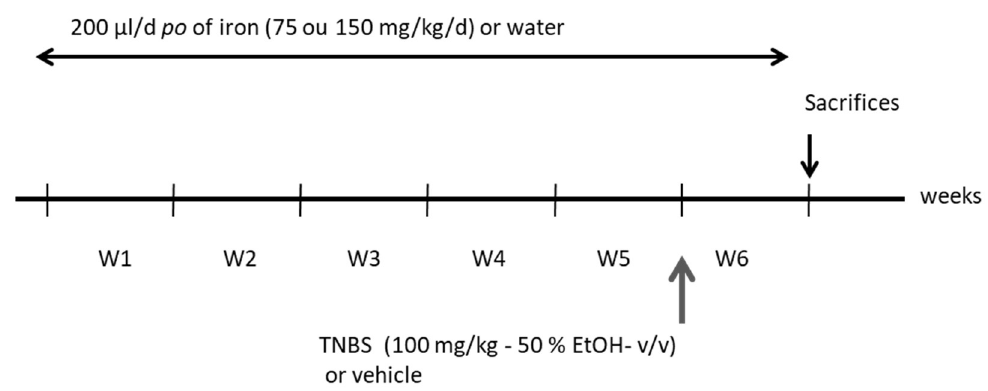
Figure 1. The experimental design of the 6-week-long study (W1 to W6). Animals received 200 µ L / day of either ferric iron (75 or 150 mg / kg / day po ) or water during the 6 weeks. Animals received trinitrobenzene sulfonic acid (TNBS) (100 mg / kg) or its vehicle during week 6 and were kept for seven days before